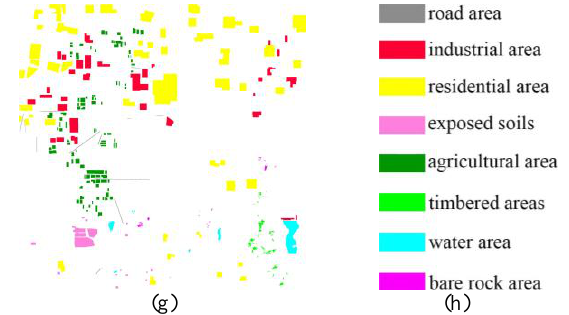
Fig.5 Multi-temporal HR GF data sets. Red–green–blue composite images of (a) source image of GF1, (c) target image of GF1, (e) source image of GF2, and (f) target image of GF2. Labeled data for (b) source image of GF1, (d) target image of GF1, and (g) both source image and target image of GF2. Class names of GF data sets